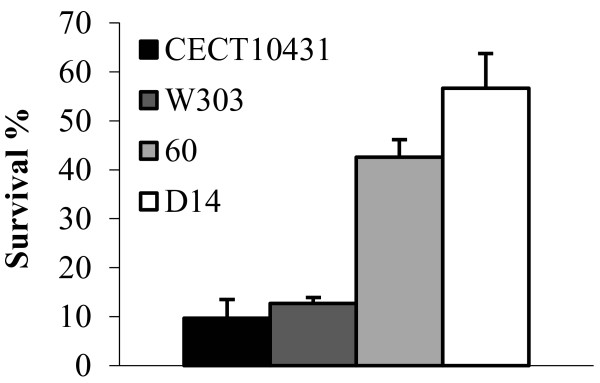
Survival percentages comparison of virulent and non-virulent strains after oxidative stress. The different strains were exposed to 6 mM HO for 1 hour and then plated in YPD media for colony counting. Percentages were calculated comparing with untreated cells. Averages and standard errors of independent triplicates are shown.